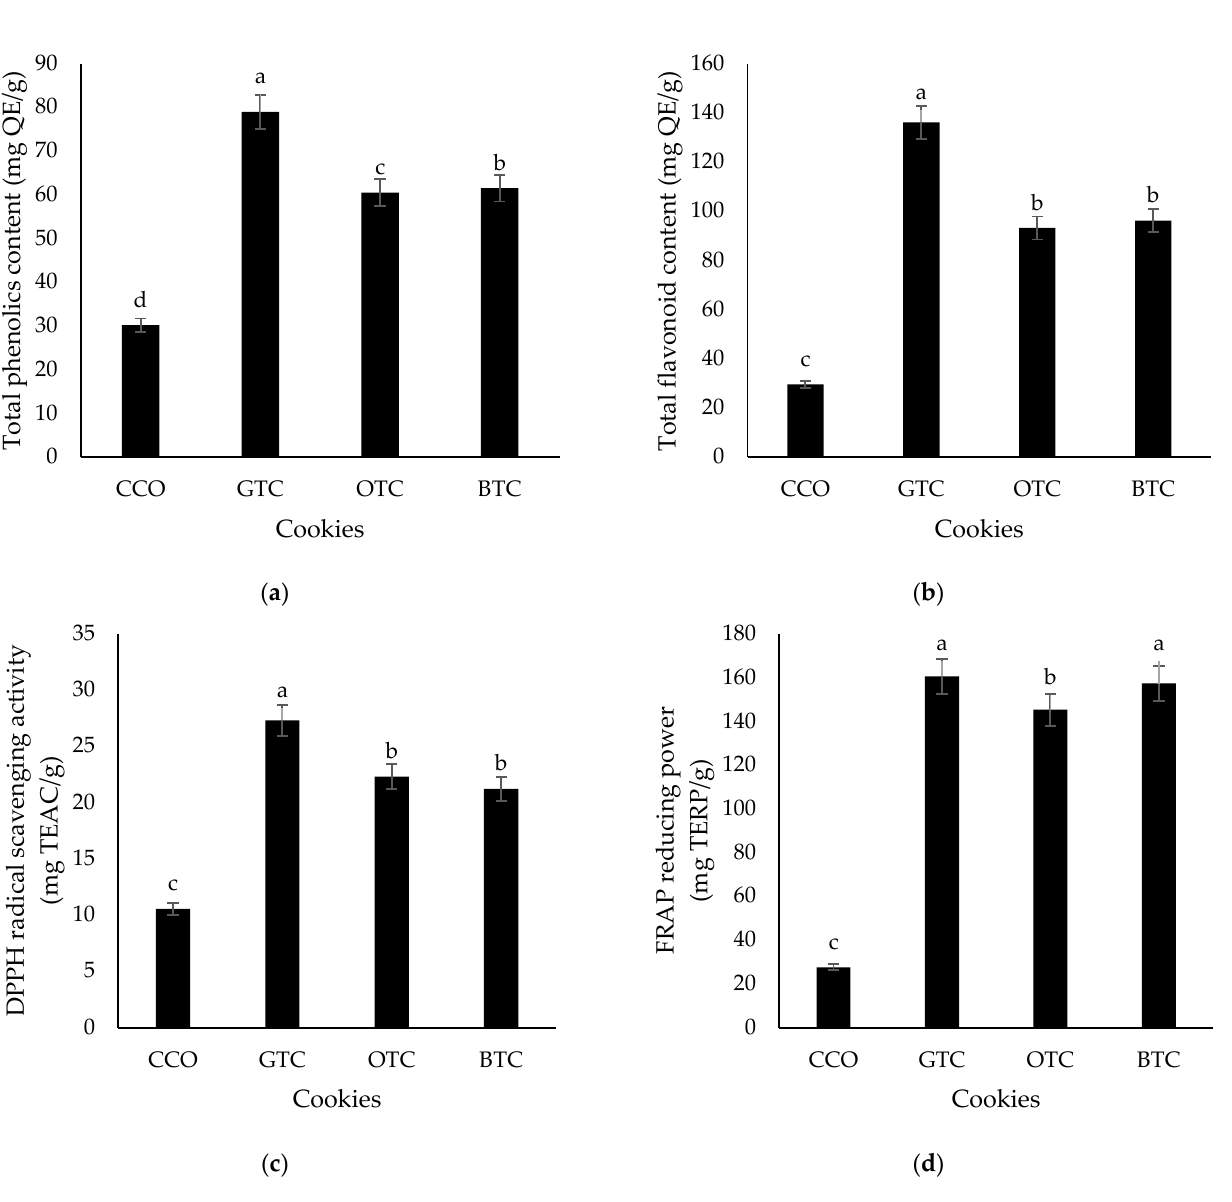
Figure 2. The antioxidative properties ( a ) total phenolics content, ( b ) the total flavonoid content, ( c ) DPPH radical scavenging activity, and ( d ) ferric reducing antioxidant power (FRAP) of non-gluten shortbread cookies with various spent tea leaf powders. The mean ± SD (n = 3). Different letters indicate significant differences between the values (Duncan’s multiple range test, p < 0.05, a–d cookie samples). CCO = control; GTC = non-gluten shortbread cookie with spent green tea leaves powder; OTC = non-gluten shortbread cookies with spent oolong tea leaves powder; and BTC = non-gluten shortbread cookies with spent black tea leaves powder.